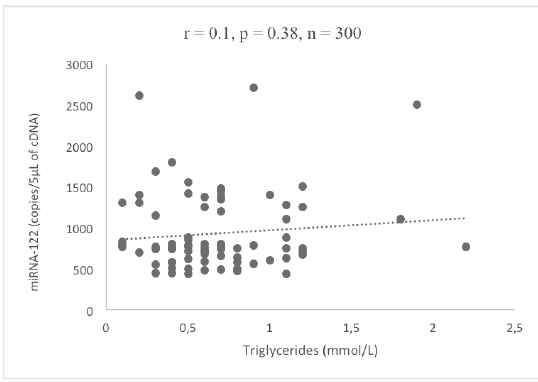
Figure 4: Correlation Graph of miRNA-122 with Triglycerides Correlation between miRNA-122 and Triglycerides was weak and not significant, r = 0.1, p = 0.38, n =